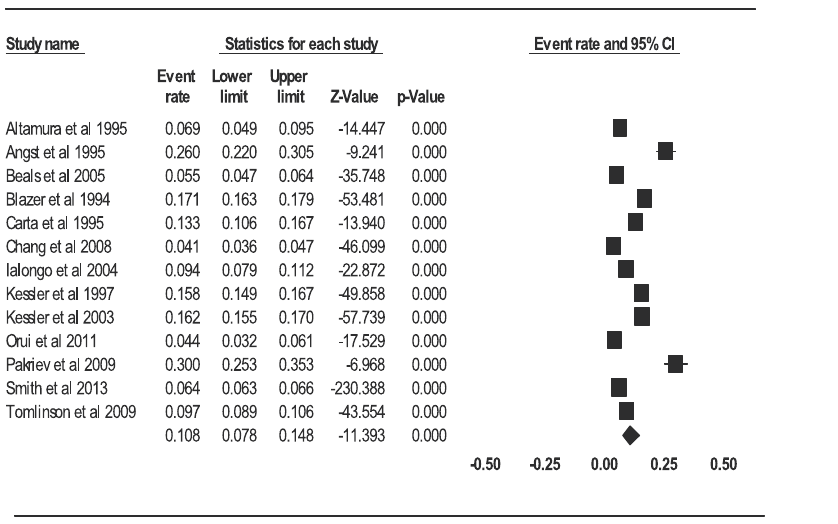
Figure 4. Forest plot of lifetime prevalence of